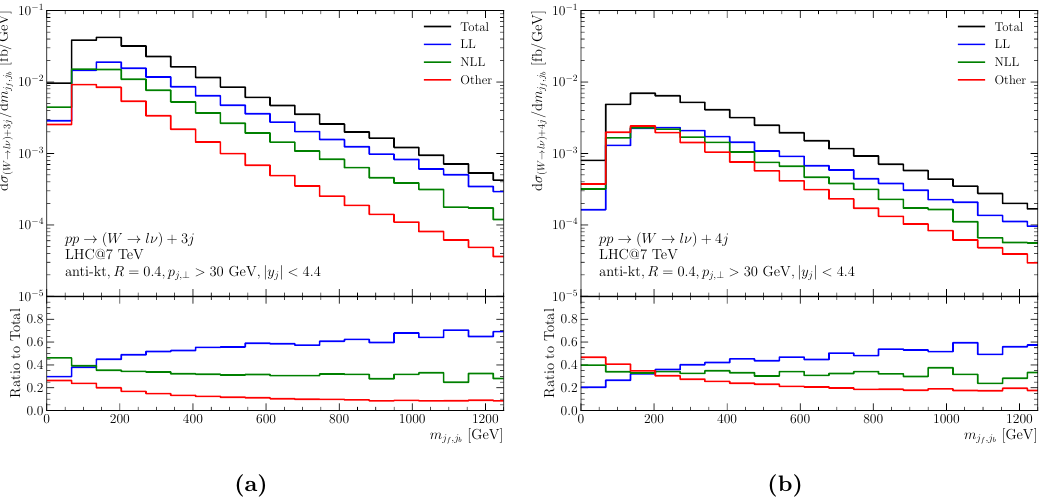
Figure 3. The leading order (a) W + 3 -jet and (b) W + 4 -jet cross sections as a function of the invariant mass between the most forward and backward jets, m (black), we also show the split into the contributions from the LL configurations (blue), NLL configurations (green) and other configurations (red). As m increase in dominance but the NLL configurations remain